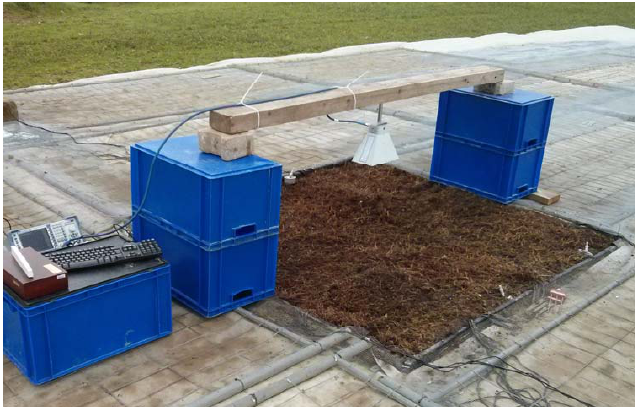
Figure 5. Pictures of the off-ground ground-penetrating radar (GPR) system fixed above the organic soils (with the vegetation layer removed) consisting of a vector network analyser connected to a horn antenna with a low-loss N-type 50 Ω impedance coaxial cable.